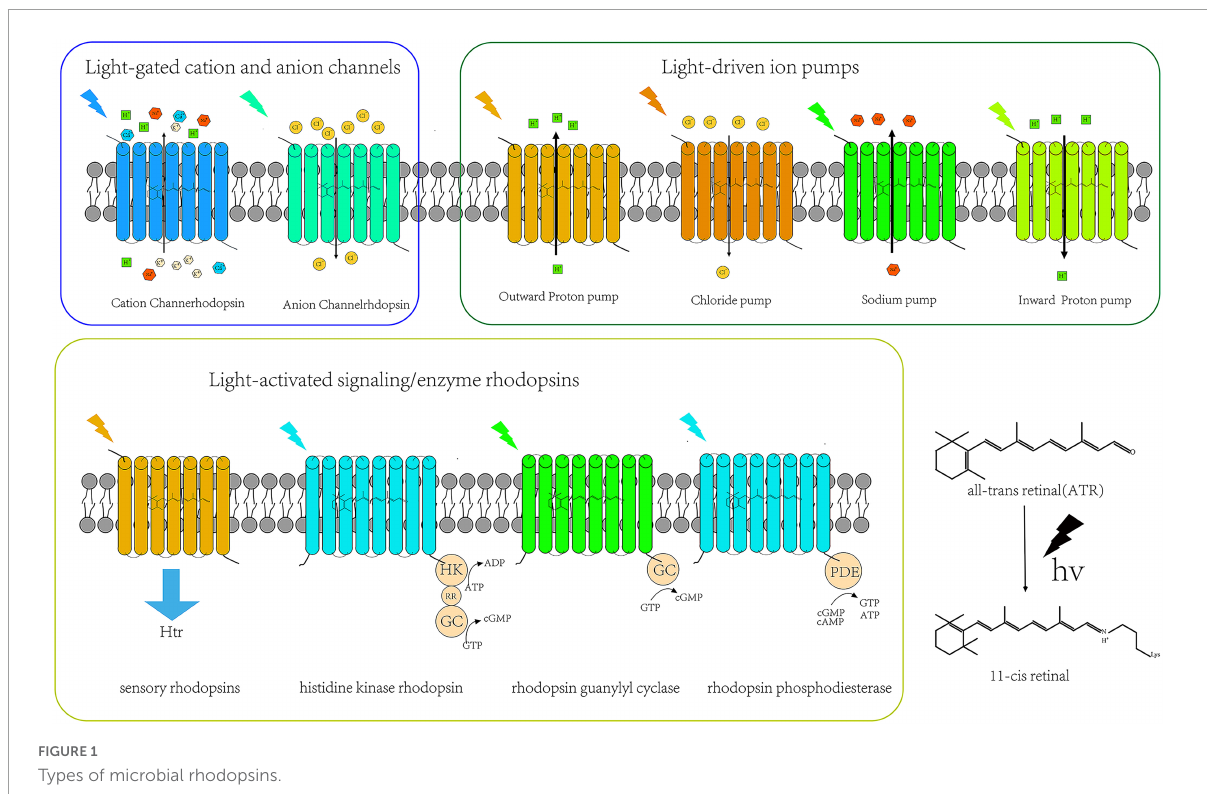
FIGURE1 Types of microbial